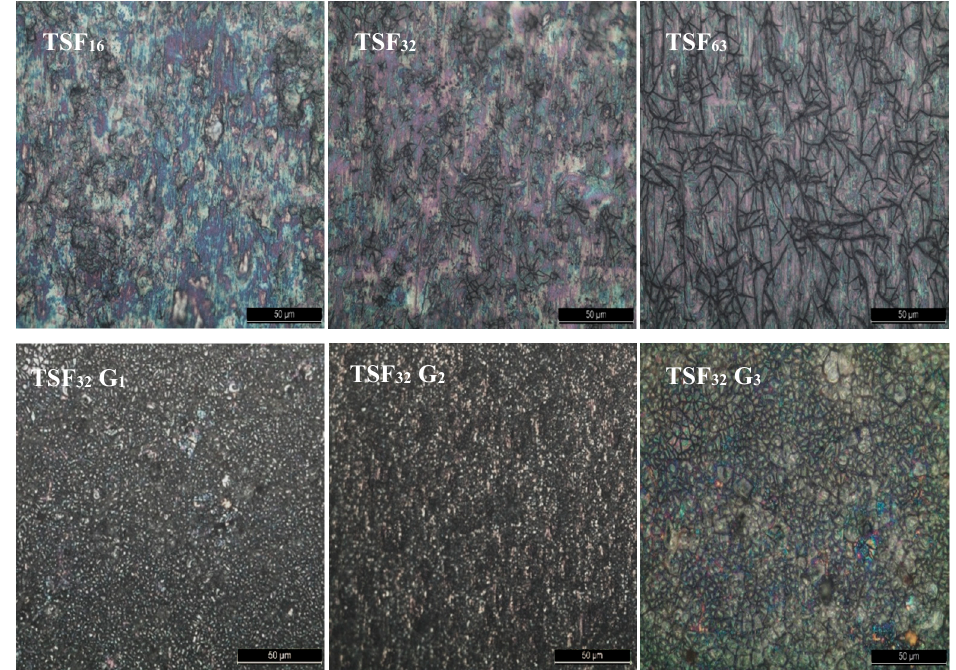
Figure 11. The optical microscopy images of the structure of the TSF and TSF 32 G coated films.